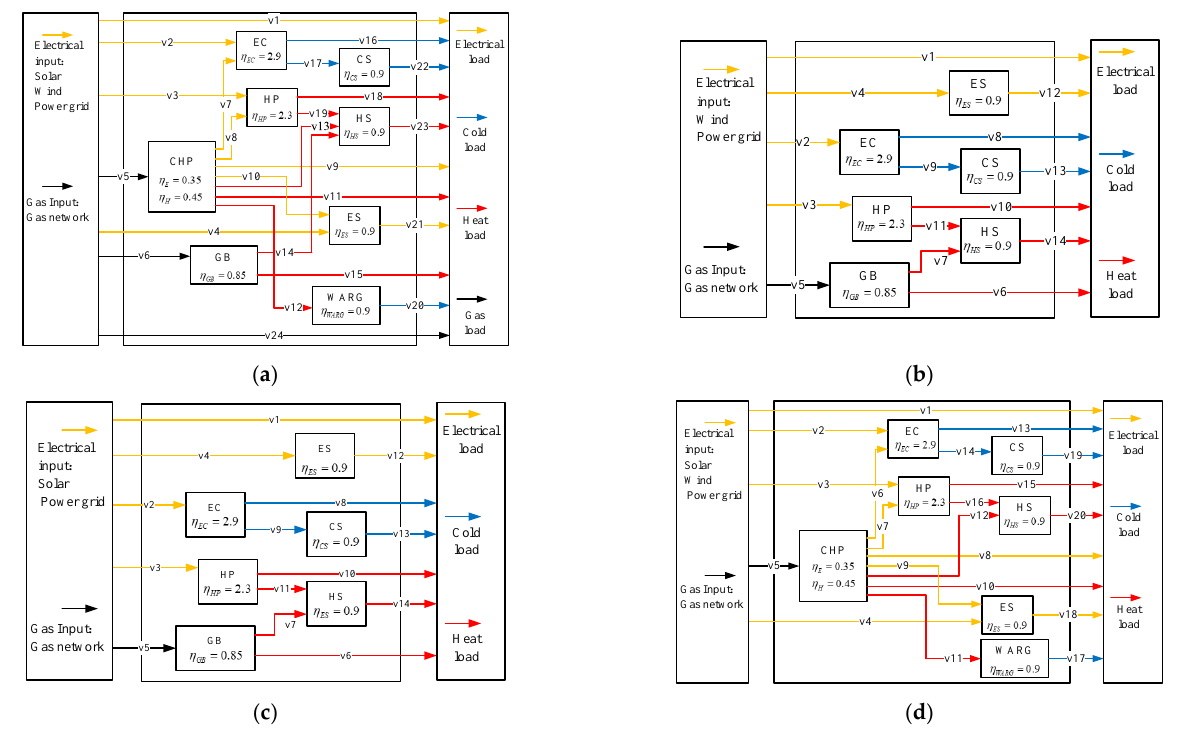
Figure A1. Structure configuration of each PIES: ( a ) PIES 1 structure configuration; ( b ) PIES 2 structure configuration; ( c ) PIES 3 structure configuration; ( d ) PIES 4 structure configuration.